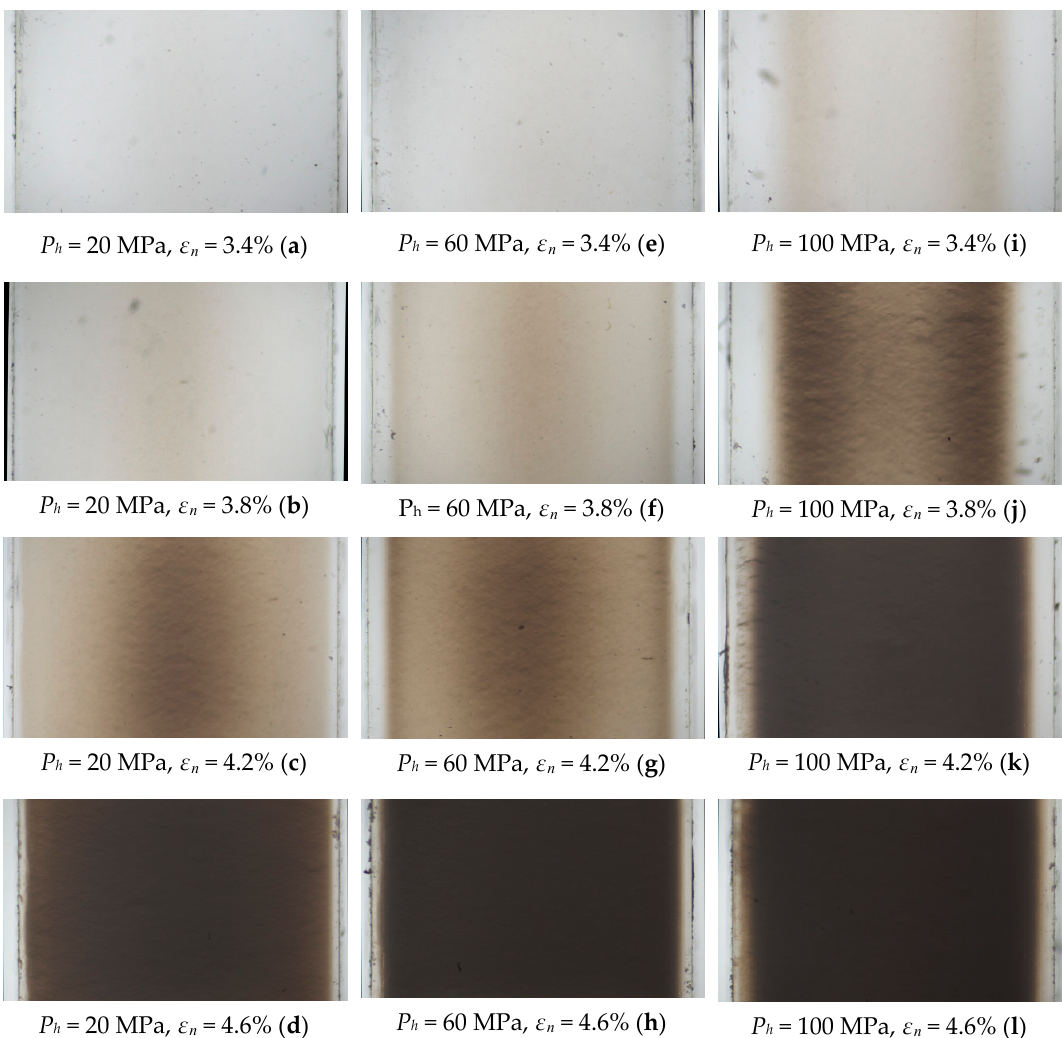
Figure 4. Examples of microscopic photographs displaying differences of stress whitening in relation to holding pressure ( P h ) and elongation ( ε n ) (width of samples: x = 6mm).